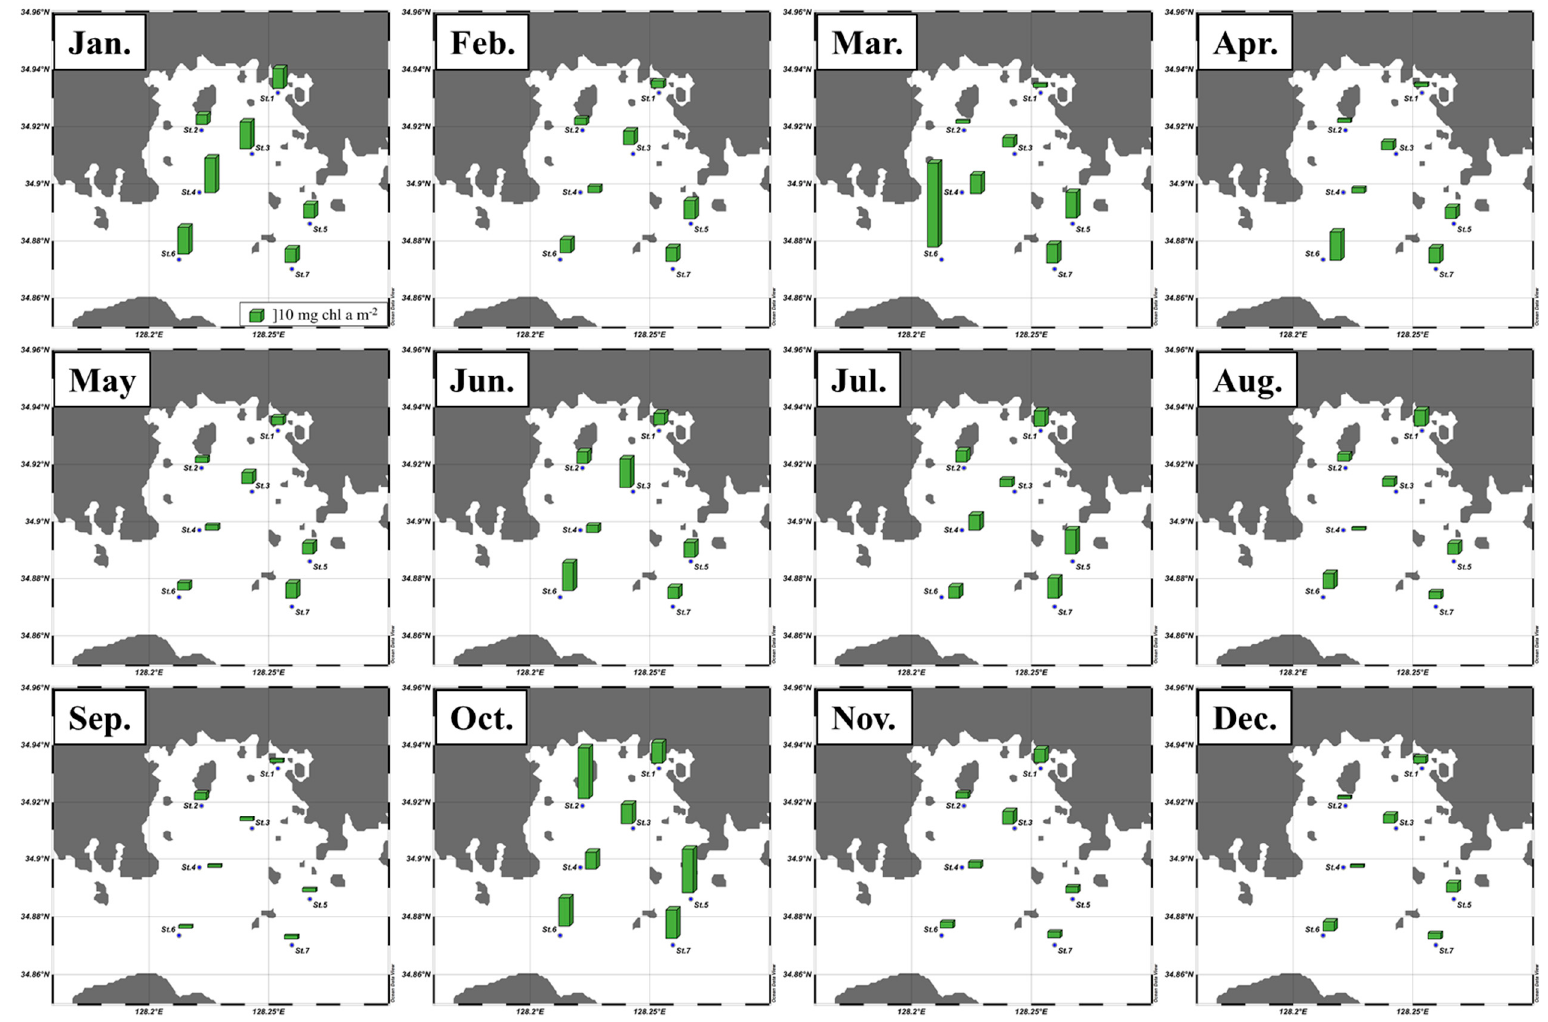
Figure 2. Water column-integrated chlorophyll a concentrations at the sampling stations in Jaran Bay.